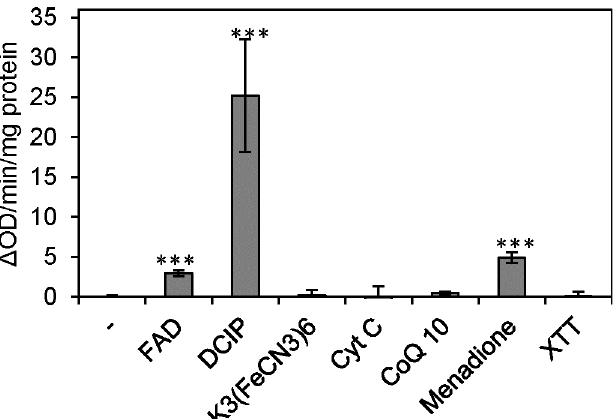
menadione, 340 nm; K 3 (FeCN 3 ) 6 , 420 nm; cytochrome c, 550 nm; CoQ 10 , 340 nm; XTT, 480 nm. *** , P < 0.001. Data obtained at least in triplicates.